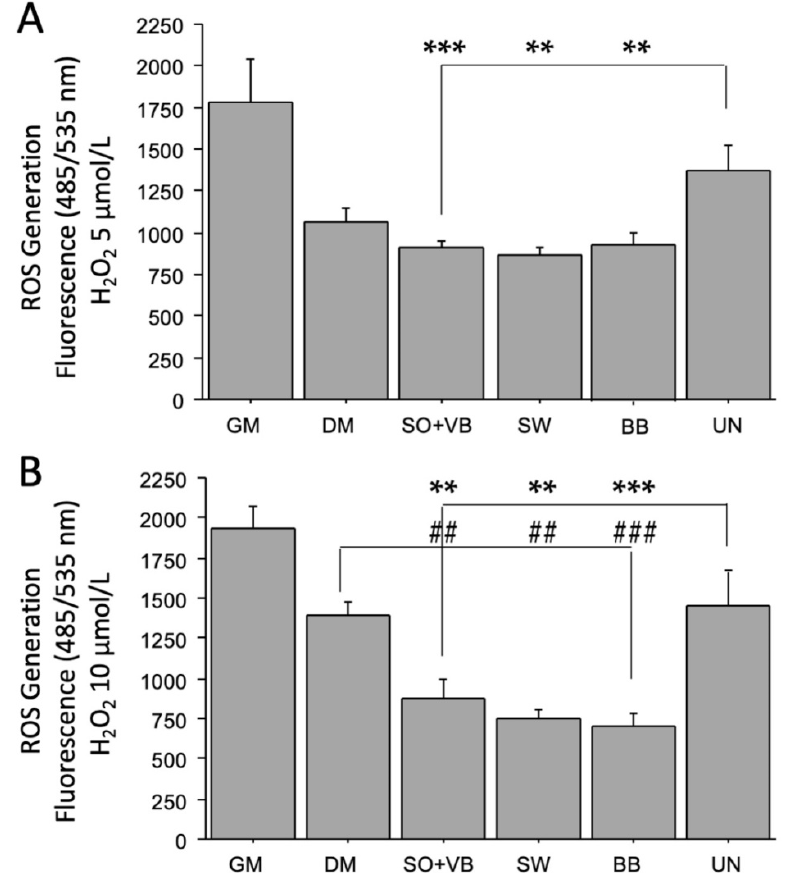
Figure 3. Reactive oxygen species (ROS) measured by the 2 (cid:48) ,7 (cid:48) -dichlorofluorescin diacetate (DCFDA) assay. Sera-treated LHCN-M2 cells were insulted with increased H 2 O 2 concentrations: ( A ) 5 µ mol/L, ( B ) 10 µ mol/L. Data comparison between groups was performed using the Student’s t -test. Data expressed as mean ± SEM of three independent experiments. *** p < 0.001 or ** p < 0.01 vs. UN; ### p < 0.001 or ## p < 0.01 vs. DM.